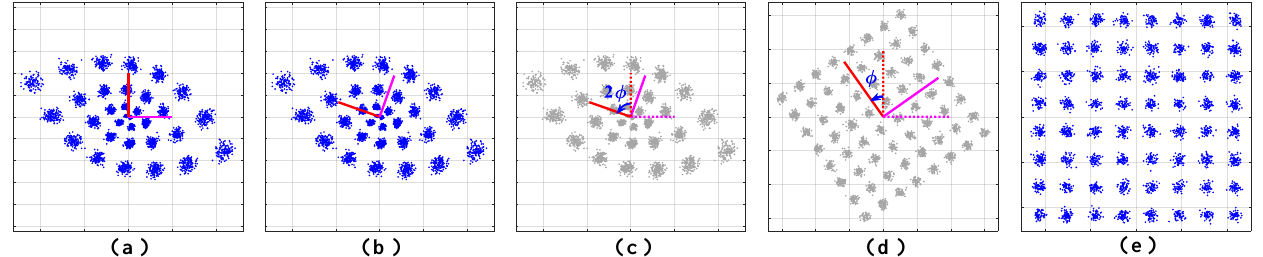
Figure 3. The process diagram of principal axes corresponding based on PCA (64QAM for example). ( a ) The projections of signals on the real and imaginary axes after the square operation; ( b ) The principal axes formed by eigenvectors of covariance matrix; ( c ) The phase rotation of principal axes with respect to the original axes after the square operation; ( d ) The phase rotation of principal axes with respect to the original axes before the square operation; ( e ) Signals after principal axes correcting based on